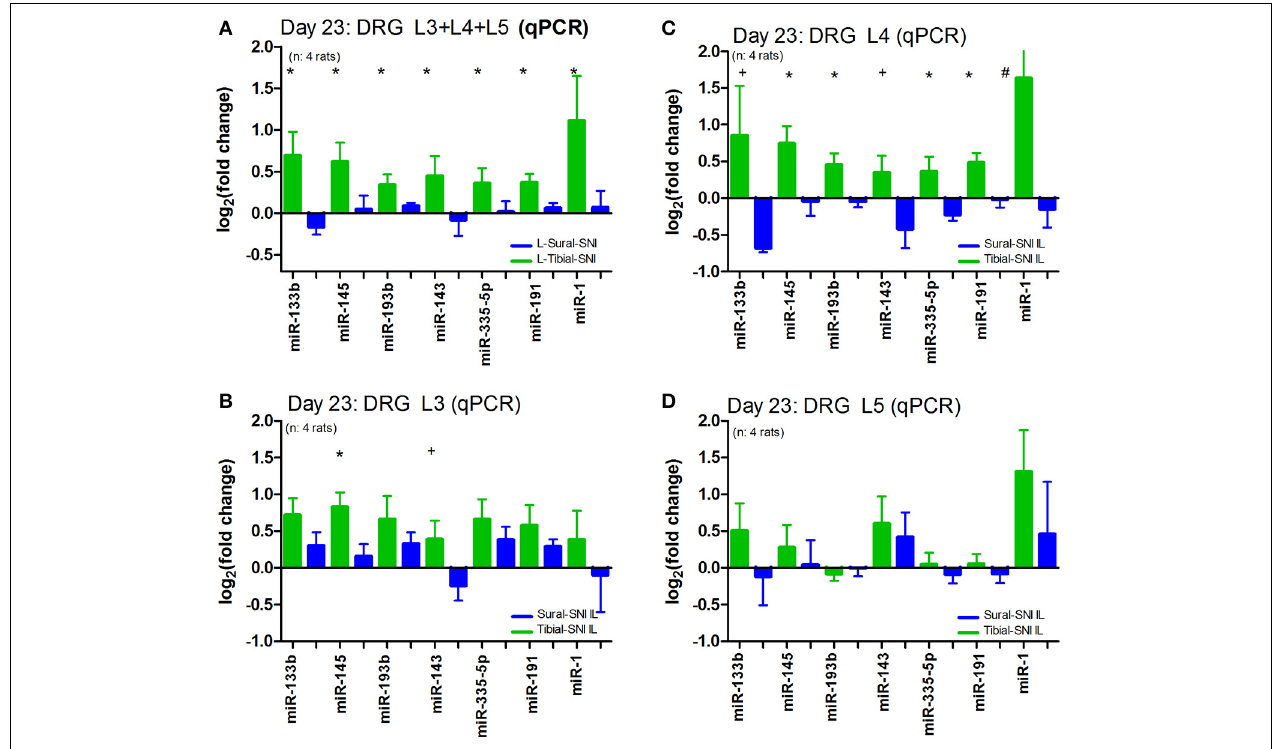
FIGURE 4 | The level of miR differential regulation is highest in ipsilateral L4-DRG as compared to ipsilateral L3-DRG and L5-DRG. For comparison purposes the expression level of the seven identified miRs is shown when the data of the three IL DRG (L3, L4, and L5) was pooled together (A) ; and for the individual IL DRG: (B) L3-DRG; (C)